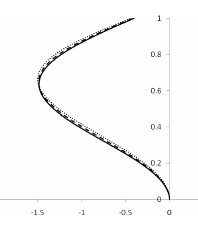
Figure 9. Modeshapes for the first mode – linear variation.